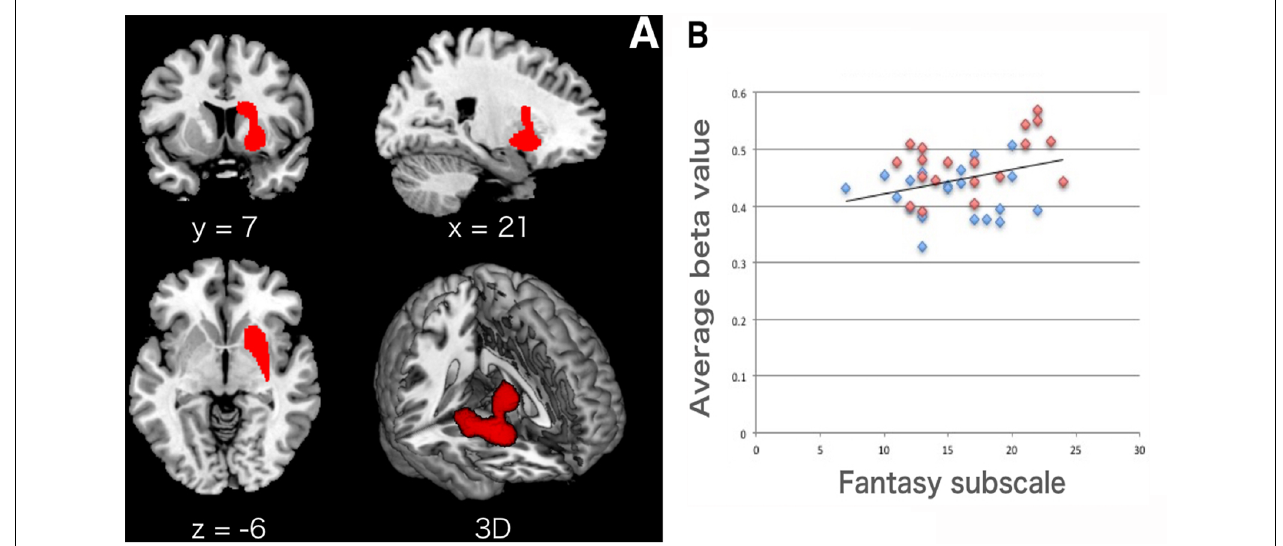
FIGURE 1 | (A) Lower gray matter volume (GMV) in the right striatum in Nurses. The location of a significant cluster in the right striatum (from the putamen to the caudate nucleus) is presented in the x, y, and z axes and in 3D. The statistical threshold for significant differences was set at false discovery rate (FDR) corrected p < 0.05 at the cluster level with uncorrected p < 0.005 at the voxel level. (B) Significant correlation between the Fantasy subscale score and the striatum. We found a significant correlation between the Fantasy subscale and the average beta value (GMV) within the significant striatum cluster [ R = 0.384 ( p = 0.046)]. The cluster average beta value was calculated using MarsBaR (http://marsbar.sourceforge.net). Blue dots, Nurses; red dots, Controls.